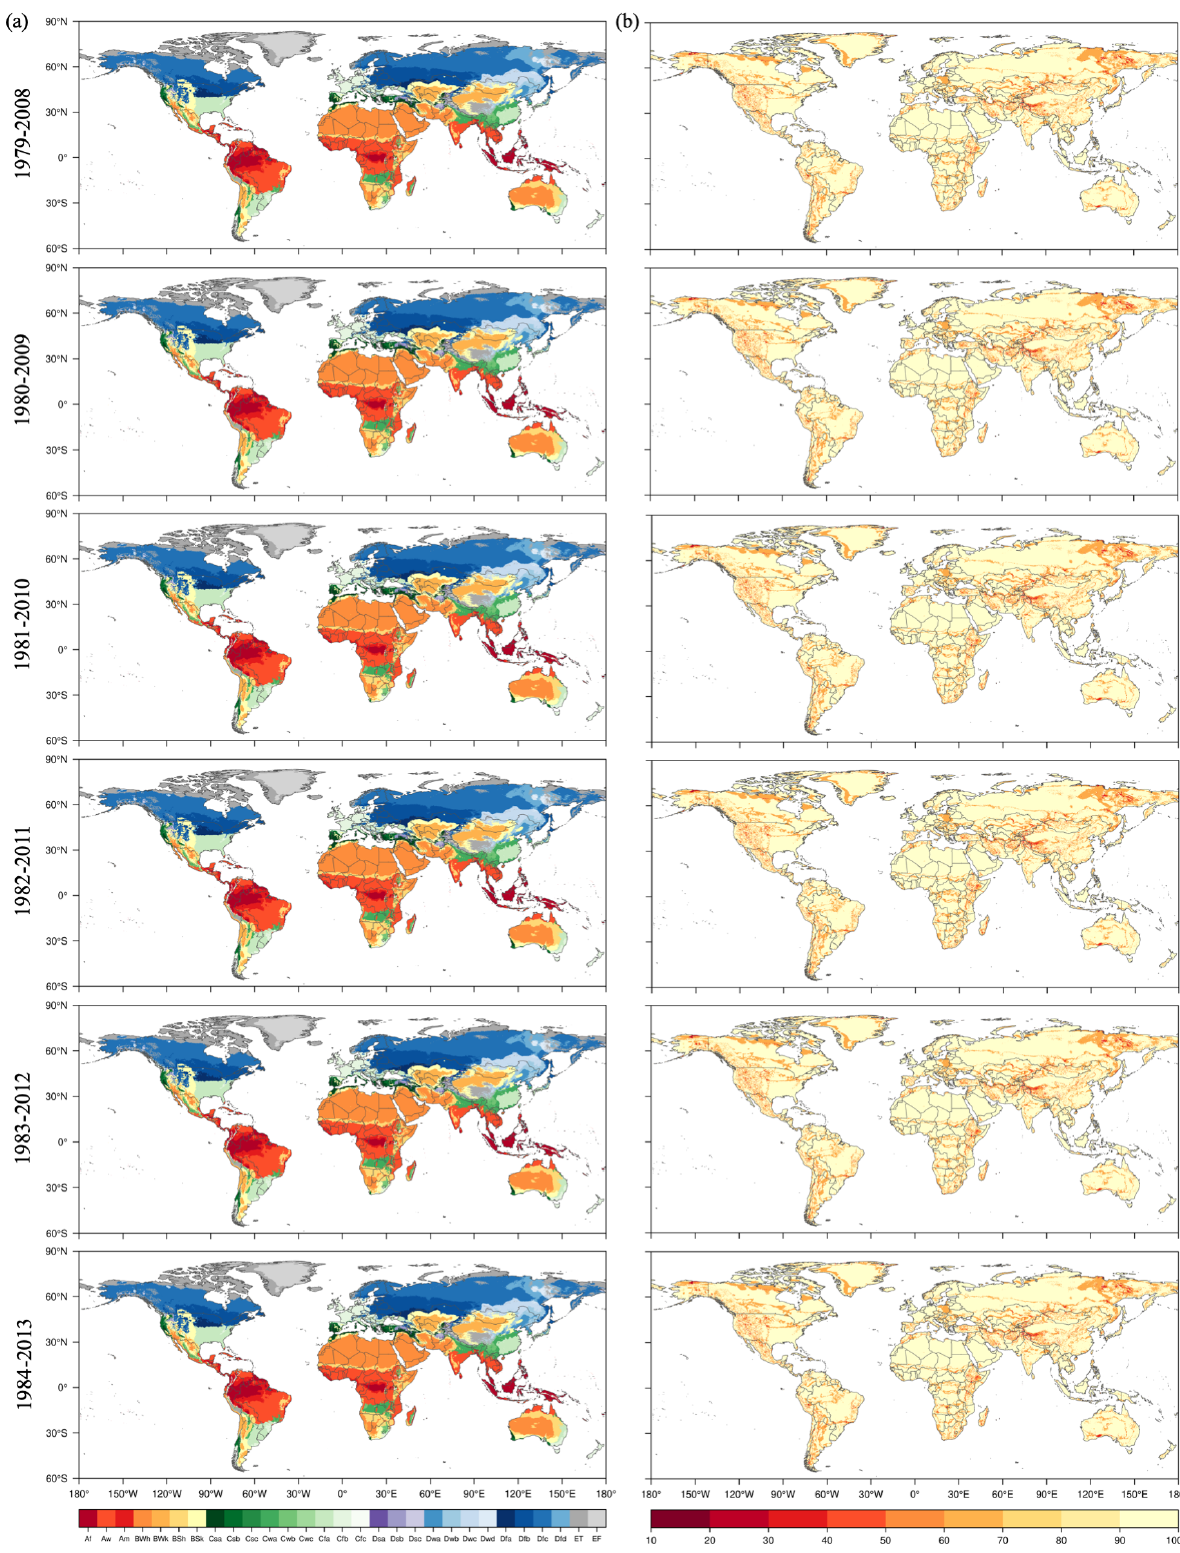
Figure 3. Global maps of the Köppen–Geiger climate classification for the historical periods (1979–2008, 1980–2009, 1981–2010, 1982– 1011, 1983–2012, 1984–2013) and associated classification confidence levels. (a) Historical maps of the Köppen–Geiger climate classifica- tion and (b) confidence levels associated with the Köppen–Geiger climate